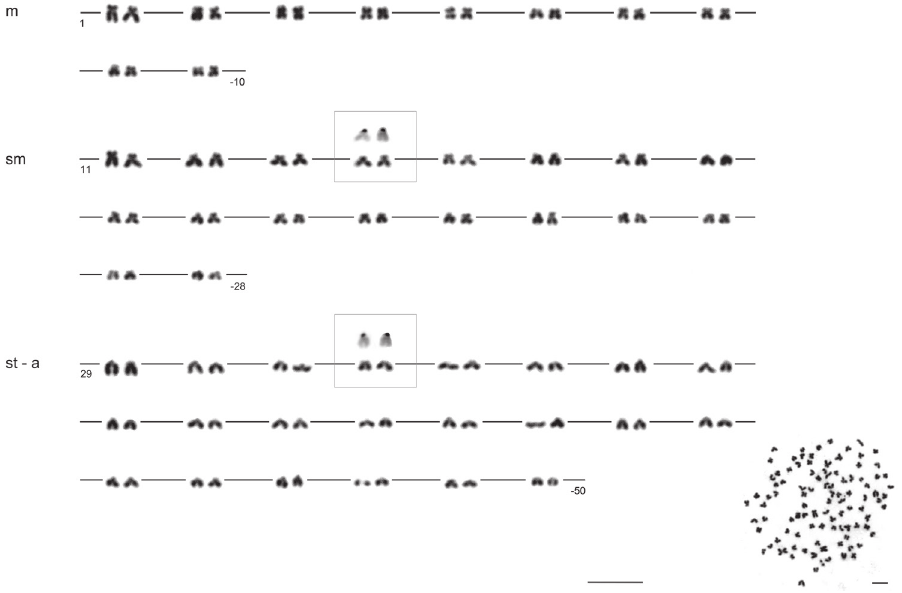
Figure 1. Karyotype of C. carassius female arranged from Giemsa-stained chromosomes (shown as inlay); m – metacentric, s – submetacentric, st – subtelocentric, a – acrocentric chromosomes. Four CMA positive (color-inverted) chromosomes (14 th pair of sm chromosomes and 32 nd pair of st-a chromosomes) are additionally shown in the frames. Bar = 10